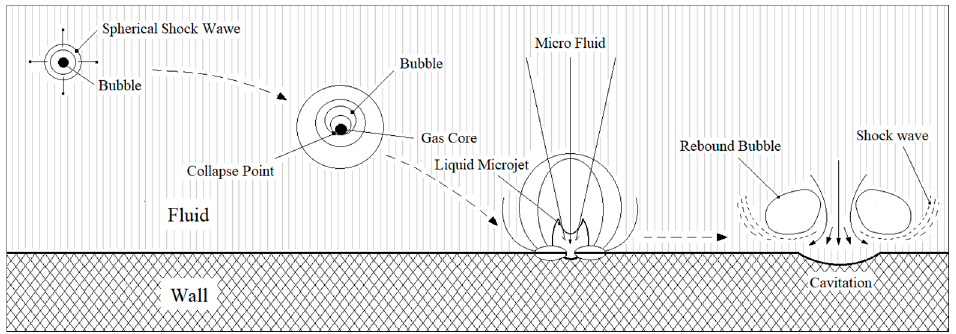
Figure 15. Schematic of bubble cavitation.